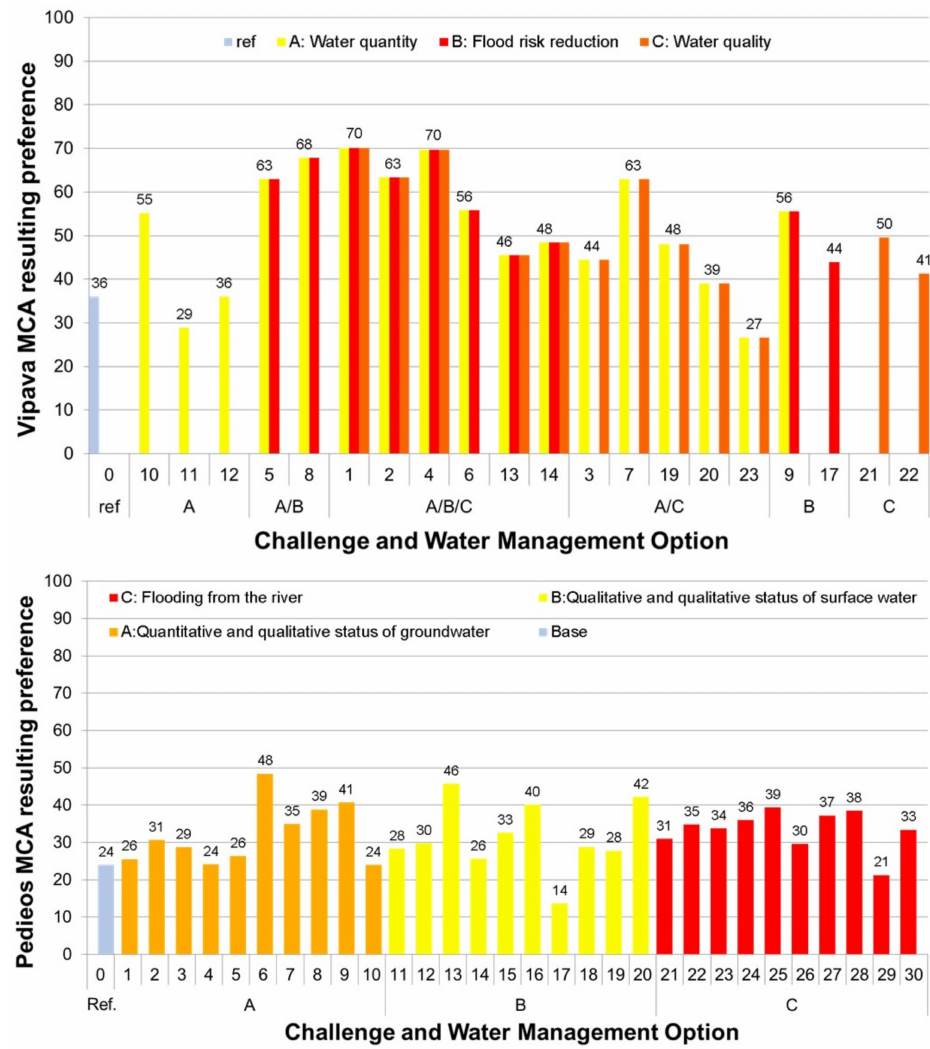
Figure 4. Multi-Criteria Analysis results based on the criteria derived from the impact assessment with the Fuzzy Cognitive Map and the characterization of the WMOs. Numbers on the x-axis refer to the WMOs for each river basin found in Tables S4–S7 in the Supplementary Materials. On the y-axis, preference values range from 0: least preferable to 100: most preferable. Bar colors represent the different challenges the WMOs were designed to tackle, which are also represented by letters in the